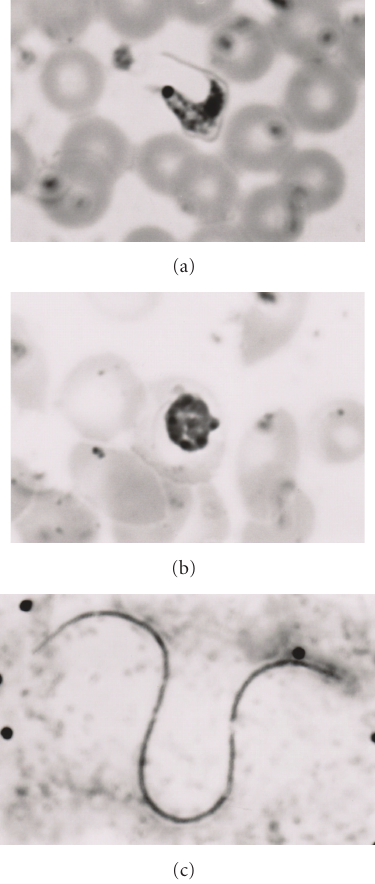
Figure 1: Microscopy . Comparison of Trypanosoma cruzi trypo- mastogote (a) with Plasmodium malariae schizont (b) and with microfilaria (c: Mansonella perstans ) in squirrel monkey blood smear. Giemsa stain: 70x oil-immersion objective (a) and (b) and 27.2x objective (c), adapted with permission of Comparative Medicine from [9].